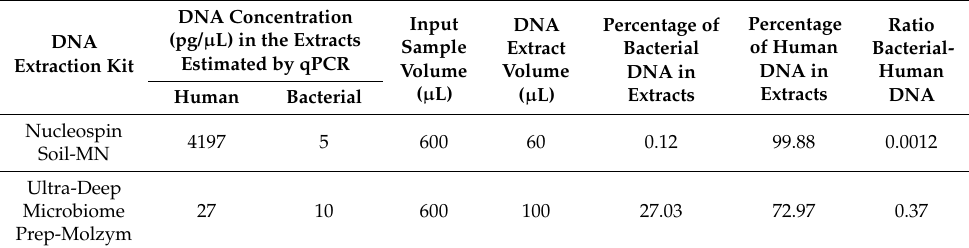
Table 1. Bacterial and human DNA yields measured by